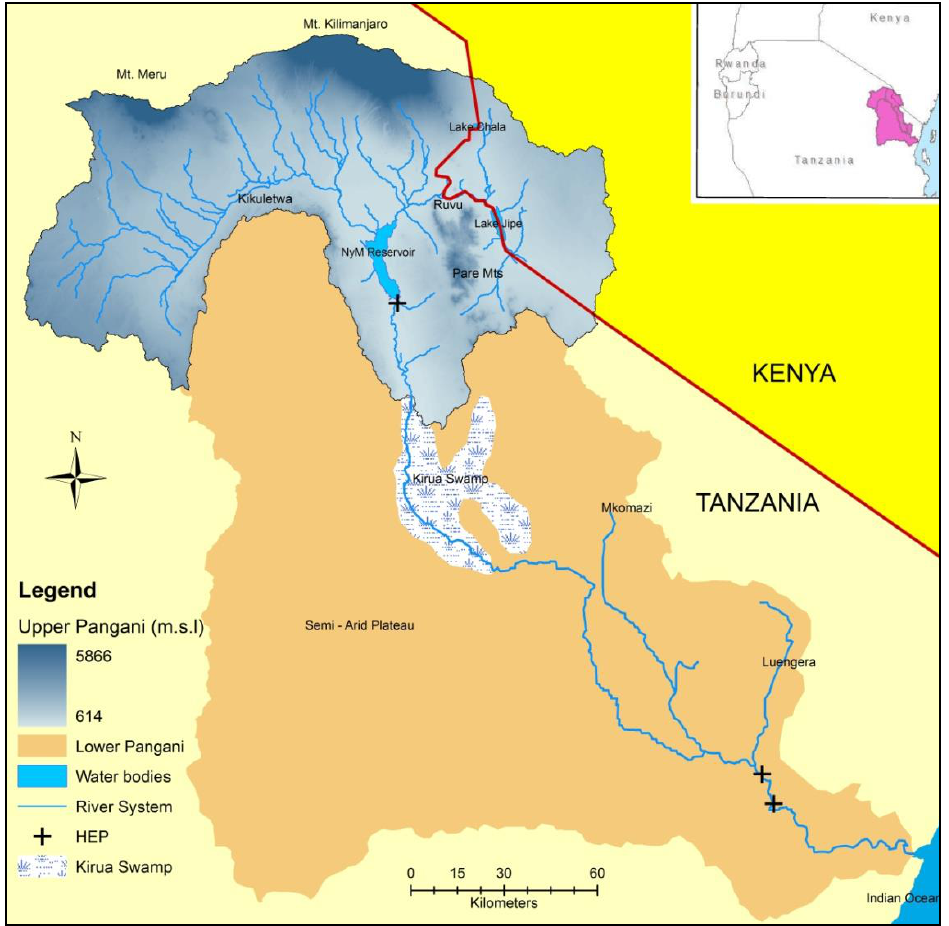
Figure 1. The Upper and Lower Pangani River Basin (HEP = Hydro-Electric Power plant).